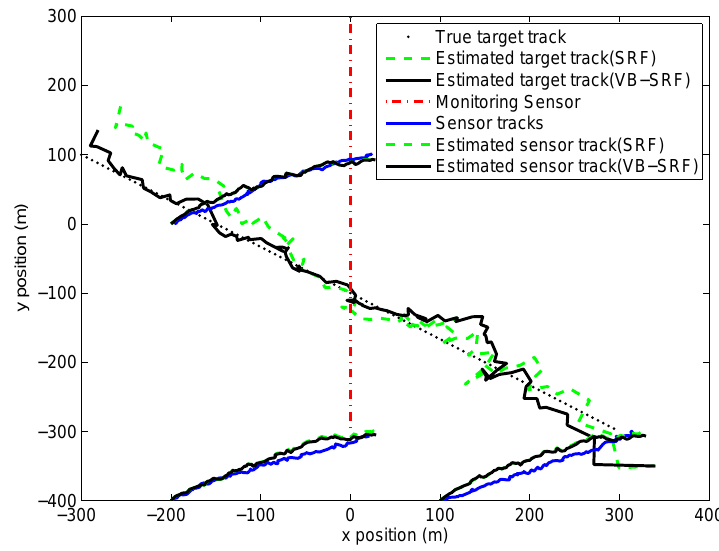
Figure 5. Typical tracks of target, drifting sonobuoy sensors, together with the estimated tracks.